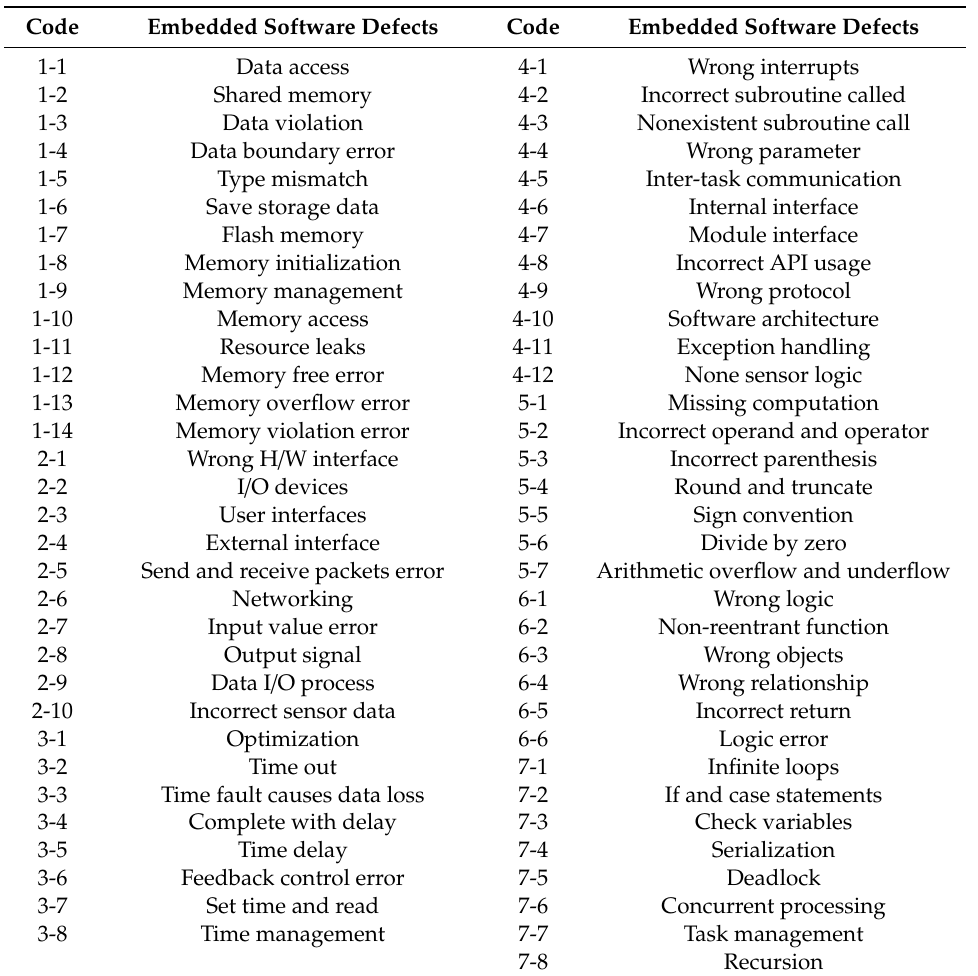
Table 7. Standardized embedded software defect